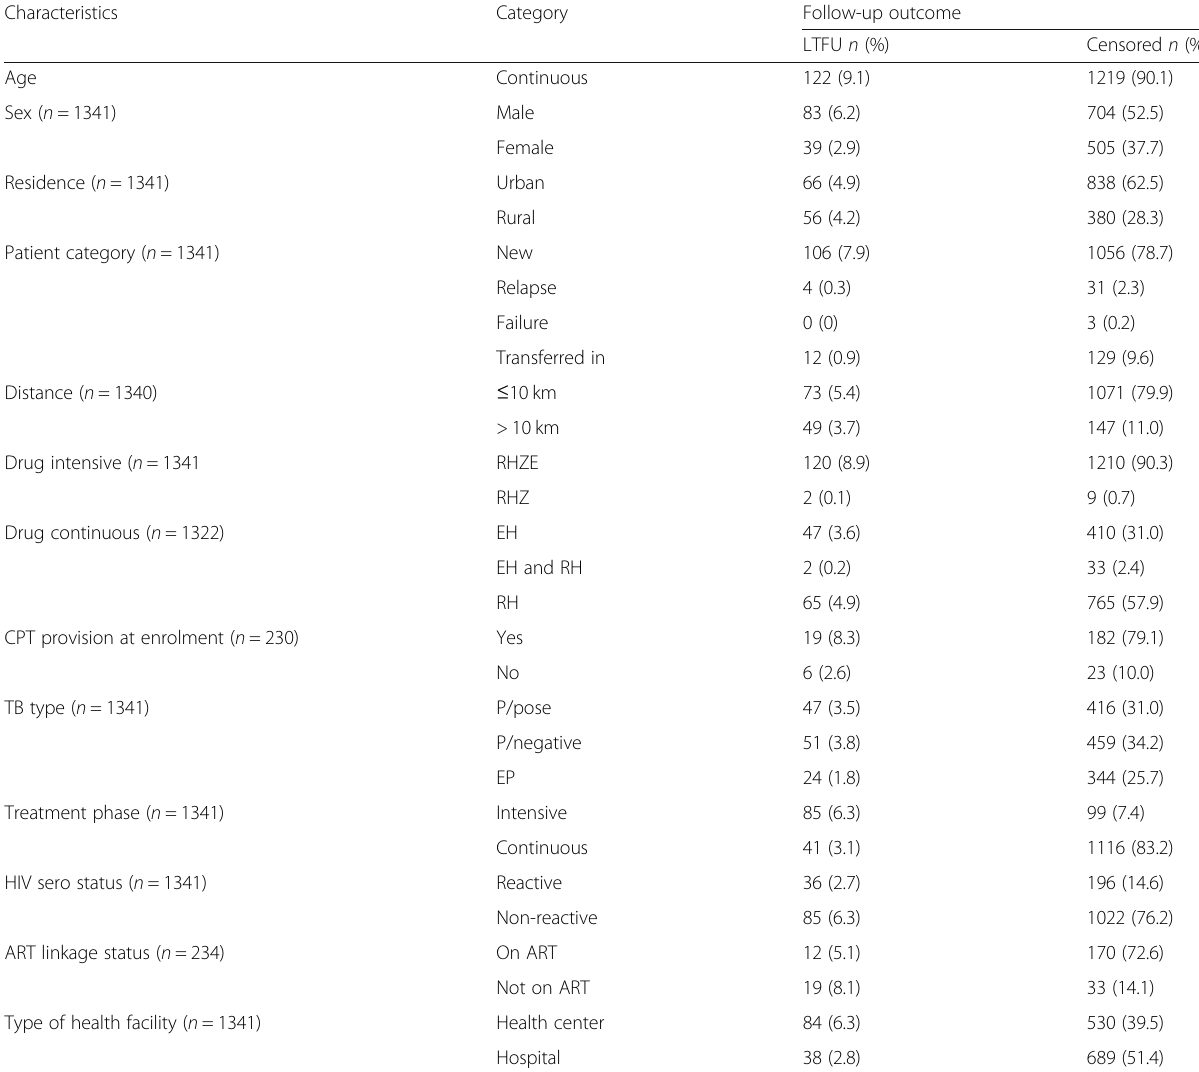
Table 2 Tuberculosis patients ’ loss to follow-up status by selected base line socio-demographic and clinical characteristics of 1341 TB patients enrolled into TB treatment and care at public health facilities, rural Ethiopia, during 2008 – 2015